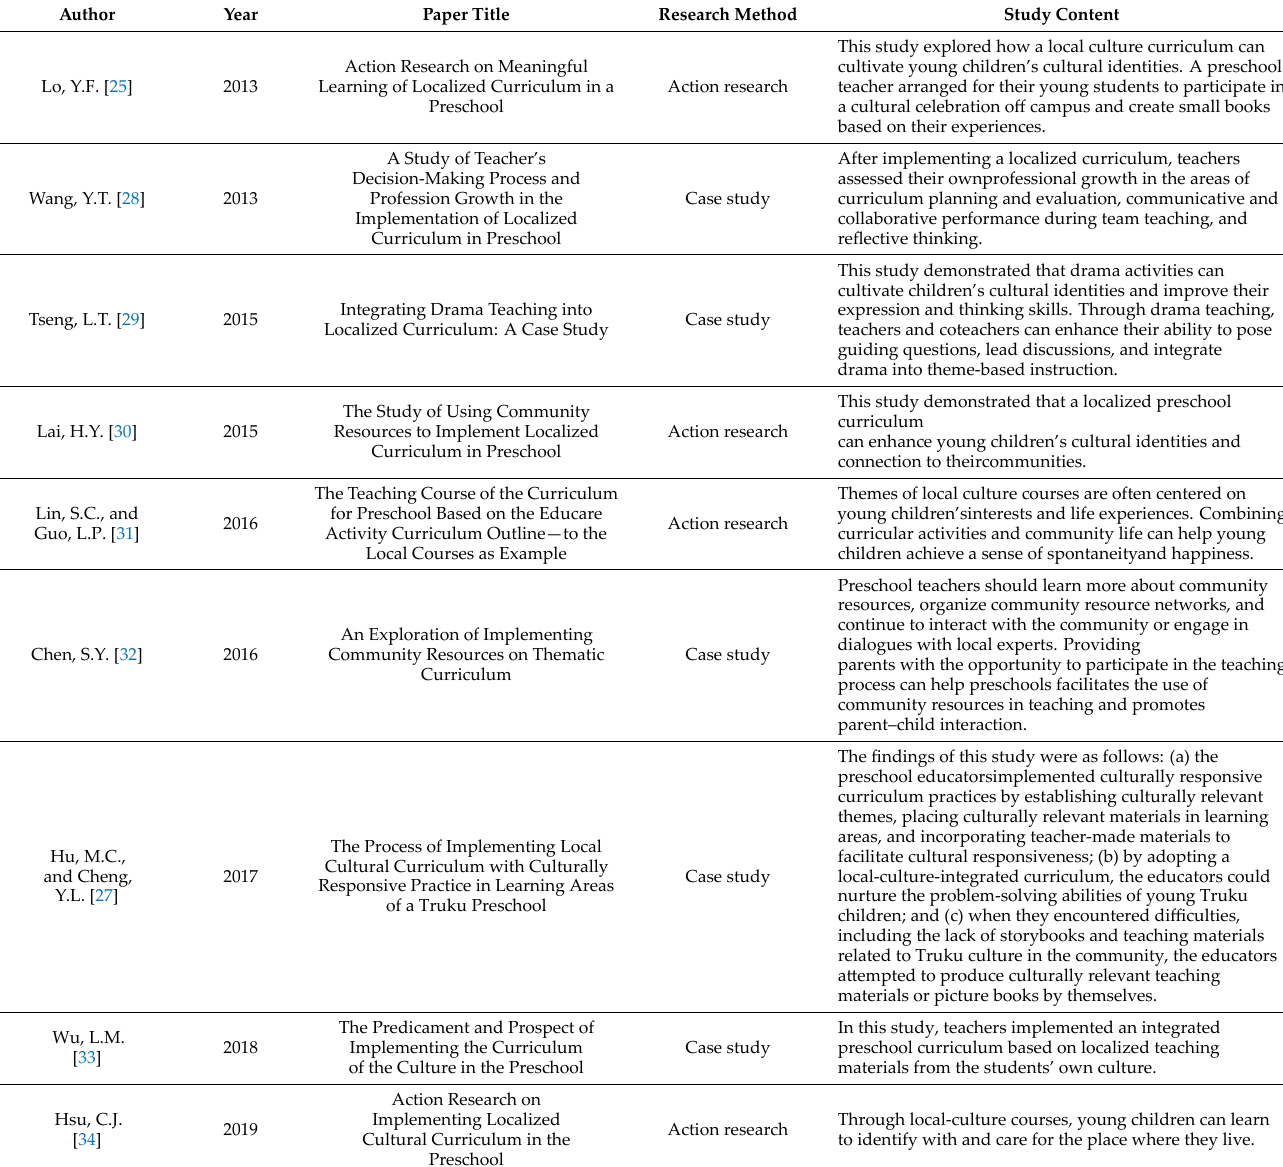
Table 1. Studies on local culture curriculum in early childhood